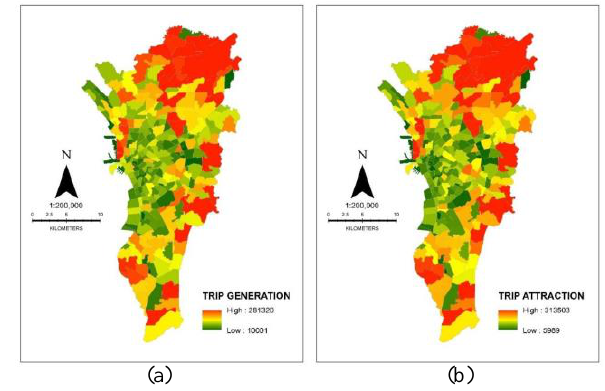
Figure 4. (a) Trip Generation and (b) Trip Attraction per TAZ